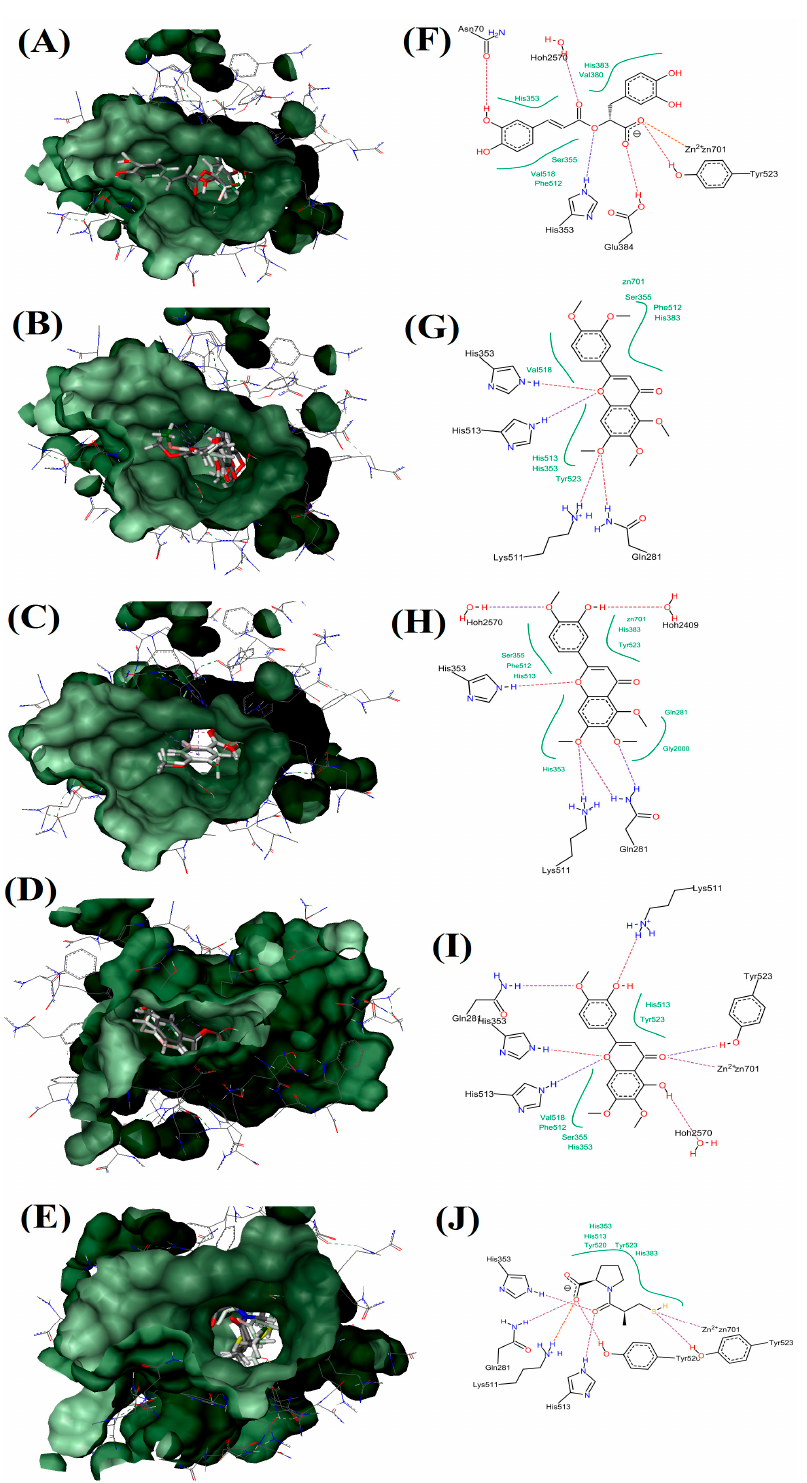
Figure 6. Visualization of ACE and OS extracts reference compounds interaction profile: Surface visualization of proteins in ACE with the ligands: RA ( A ); SIN ( B ); TMF ( C ); EUP ( D ); and Captopril ( E ). Active site residues interaction of protein in ACE with the ligands: RA ( F ); SIN ( G ); TMF ( H ); EUP ( I ); and Captopril ( J ). Hydrophobic interaction shown in green region.